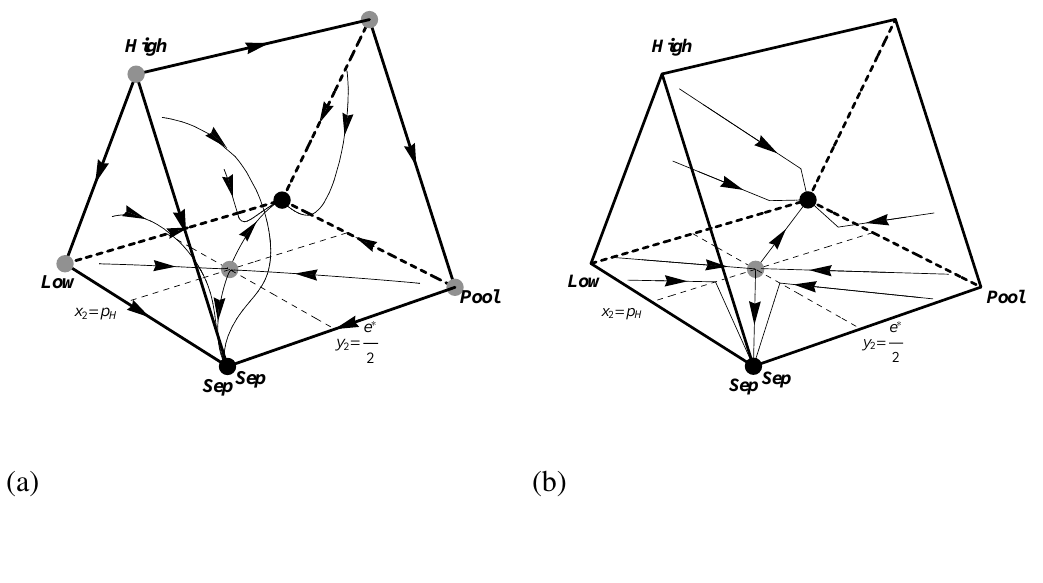
Figure 3. Phase portraits showing the dynamics of the pruned Spence signaling game with 1 < e ∗ < 2 for (a) the replicator dynamic and (b) the best response dynamic. Black and grey dots indicate stable and unstable rest points